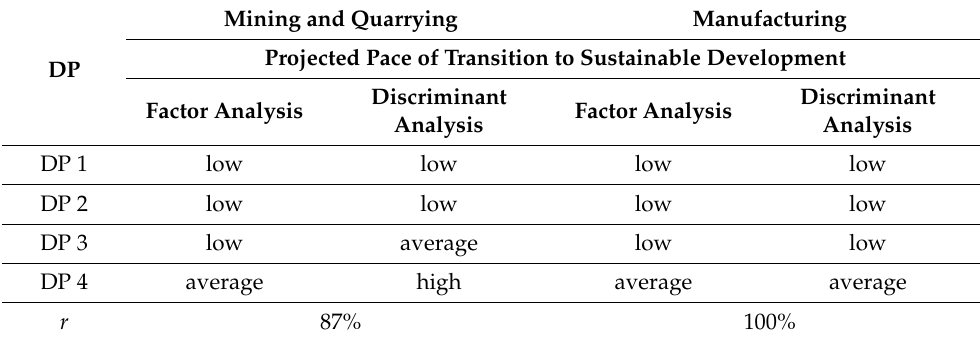
Table 8. Comparison of the results of factor and discriminant